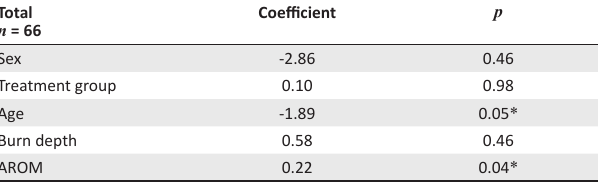
TABLE 5: Age and active range of motion as predictors of Activities Scale for Kids©p scores. Total n = 66